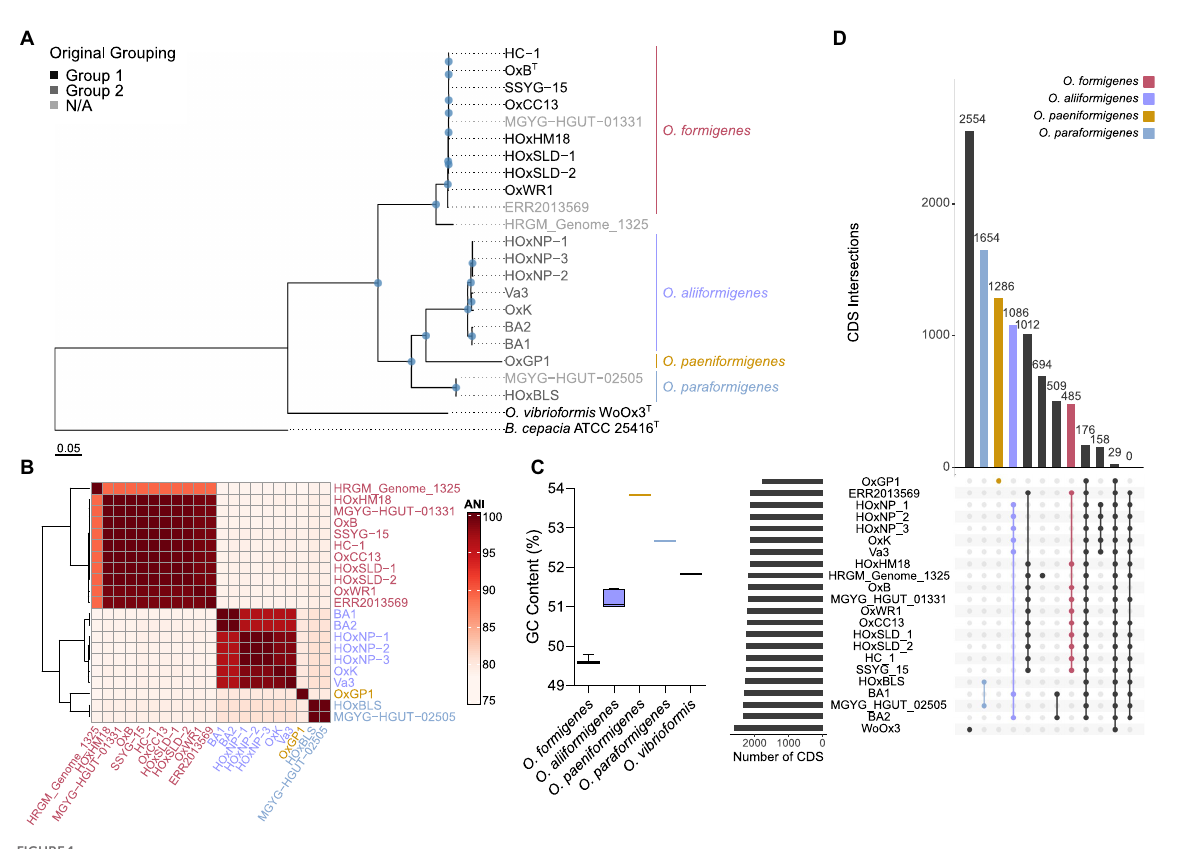
FIGURE 1 Phylogenetic evaluation of the Oxalobacter formigenes taxon. (A) Maximum likelihood phylogenetic tree constructed from 691 aligned single- copy core orthologues with B. cepacia ATCC 25416 as the outgroup. Greyscale color represents original grouping and colored bars denote new species designations. Scale bar designates mean number of amino acid substitutions per site. Blue circles denote nodes with greater than 80% bootstrap support. (B) Heatmap depicting average nucleotide identity pairwise comparisons of strains used in this study. (C) Box and whisker plot displaying the whole genome percent GC content of each of the Oxalobacter species in this study. Boxes represent first and third quartile values while black line denoting the median, and whiskers encompass maximum and minimum values. (D) Coding sequence (CDS) presence/absence plot generated from pangenome. Each column represents the intersection of CDSs in that group (denoted by the number above the column). Filled circles show strains part of the same group. The bars on left show the total number of CDSs present in each